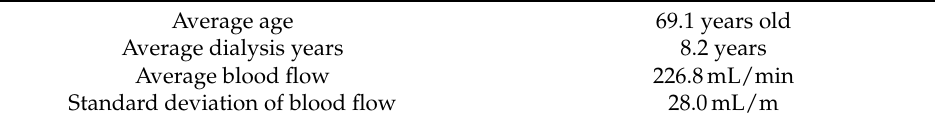
Table 2. Statics of patients.